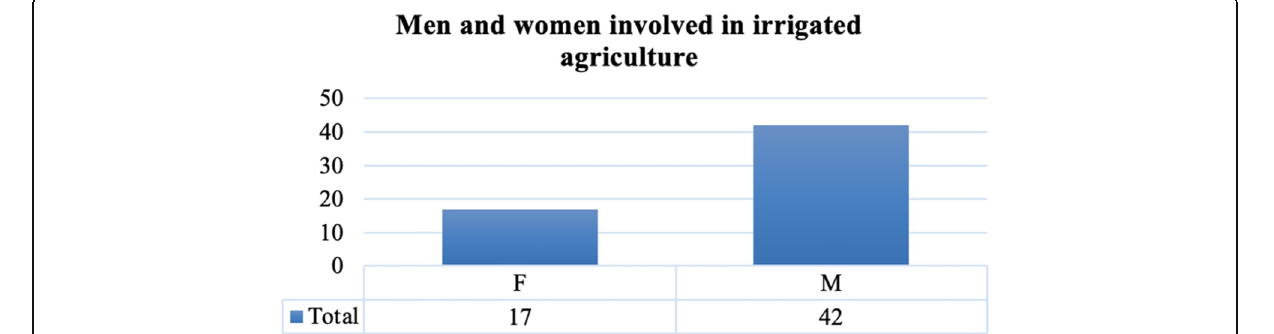
Fig. 3 Men and women involved in irrigated